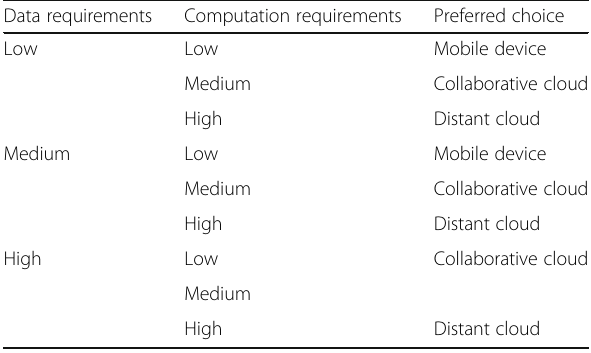
Table 6 Preferred choice criteria